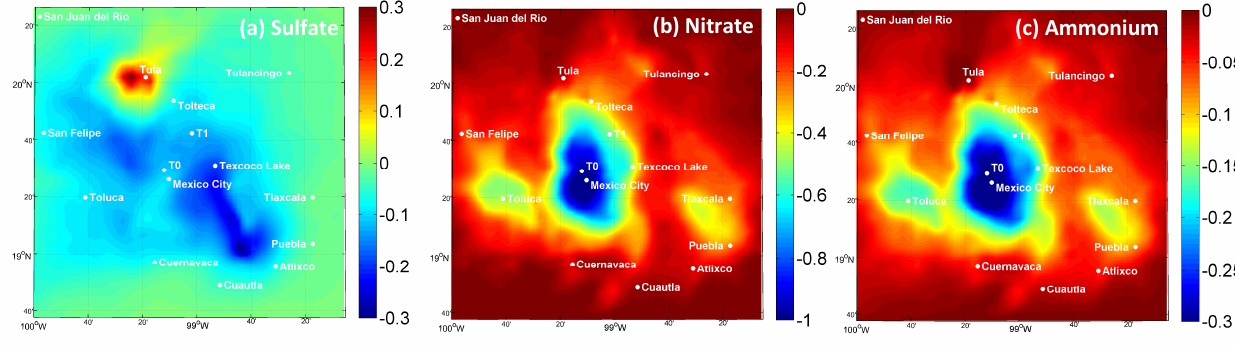
(a) sulfate, (b) 1 emissions. A negative change x